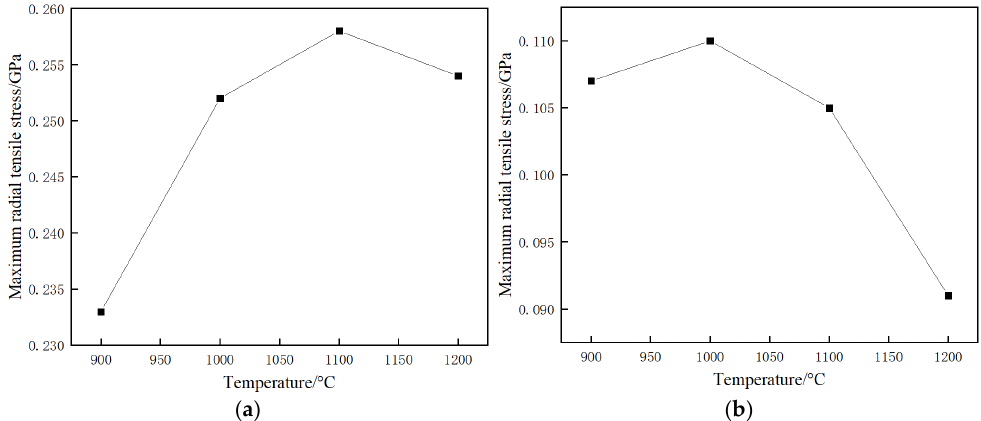
Figure 6. Relationship between the maximum radial thermal stress on the surface of the LMA layer of the ( a ) M1 and ( b ) M2S1 specimens and the operating temperatures.